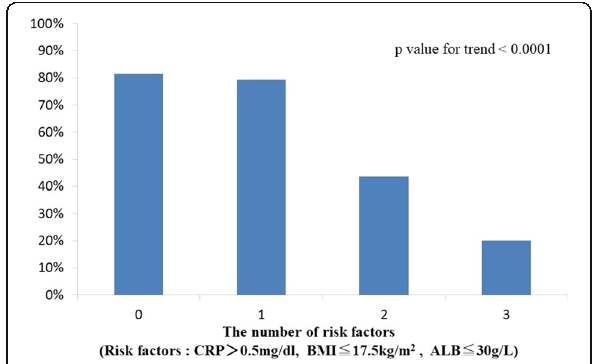
Fig. 1 The percentages of early discharge in relation to the number of risk